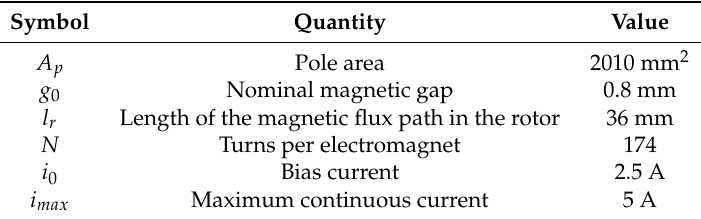
Table 3. Main parameters of the radial